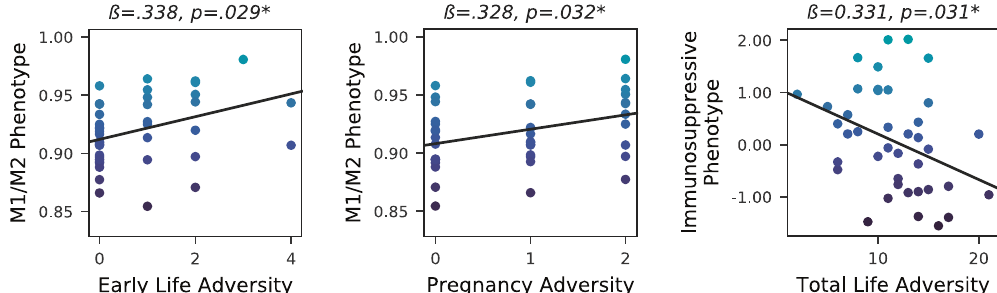
Fig. 1 Life adversity is associated with differing immune phenotypes, depending on the timing of the exposure. Note: * p < 0.05. The scatterplots above depict the unadjusted associations between self-reported interpersonal adversity across various periods of life in relation to normalized immune gene expression signatures, with color mapped to the y -axis biomarker. The M1/M2 phenotype refers to a relative increase in the expression of macrophage-associated pro-in fl ammatory M1-like genes versus anti-in fl ammatory and counter-regulatory M2- like genes. The Immunosuppressive phenotype represents a tolerant or desensitized state elicited by repeated cellular stressors (e.g., endotoxin), during which time the typical in fl ammatory response is deactivated; lower scores imply increased duration of the in fl ammatory